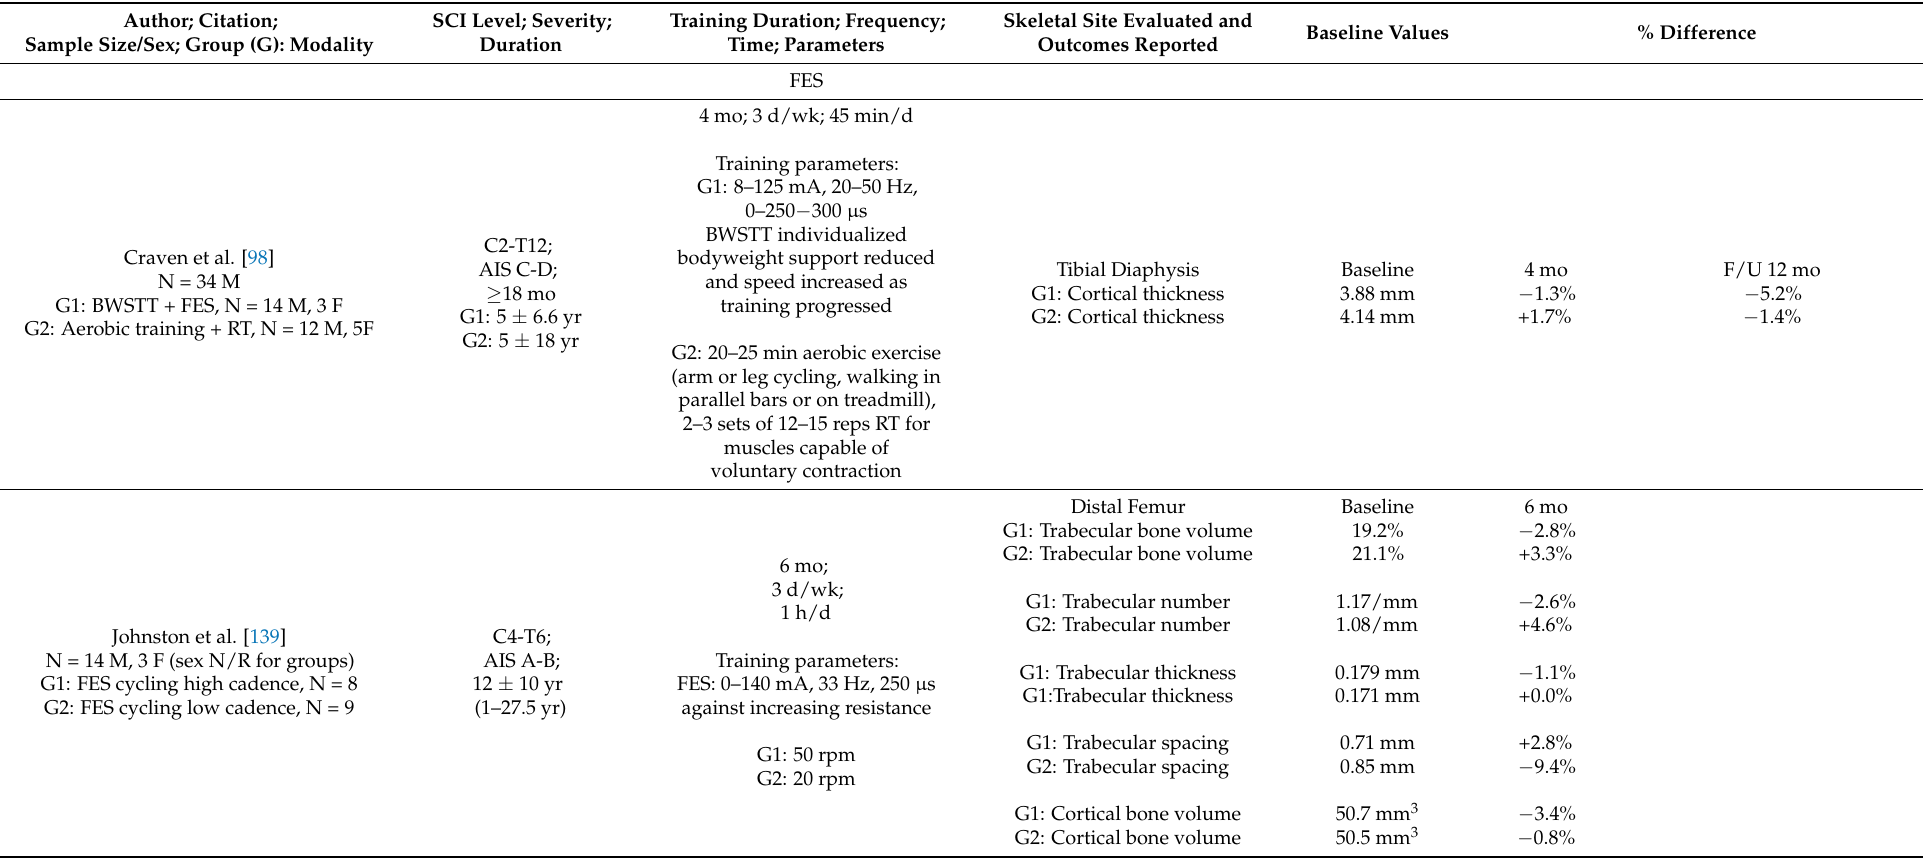
Table 6. Interventional studies evaluating the effects of activity-based physical therapy (ABPT) and/or loading on bone microstructural in adults with subacute and/or chronic spinal cord injury